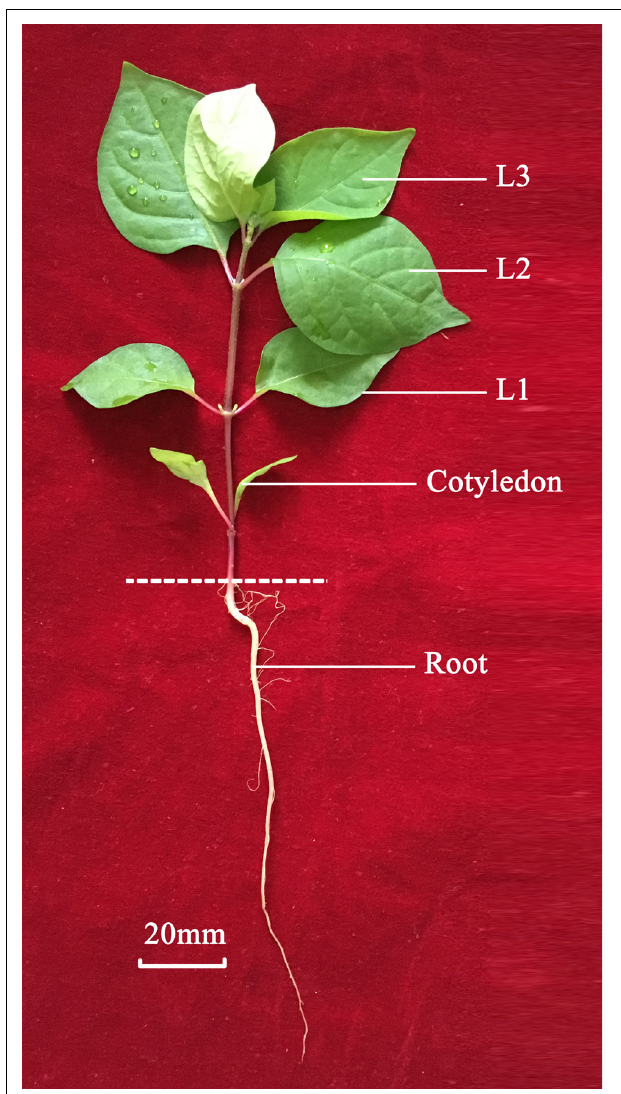
FIGURE 1 | Root and leaf of Achyranthes bidentata used for transcriptome